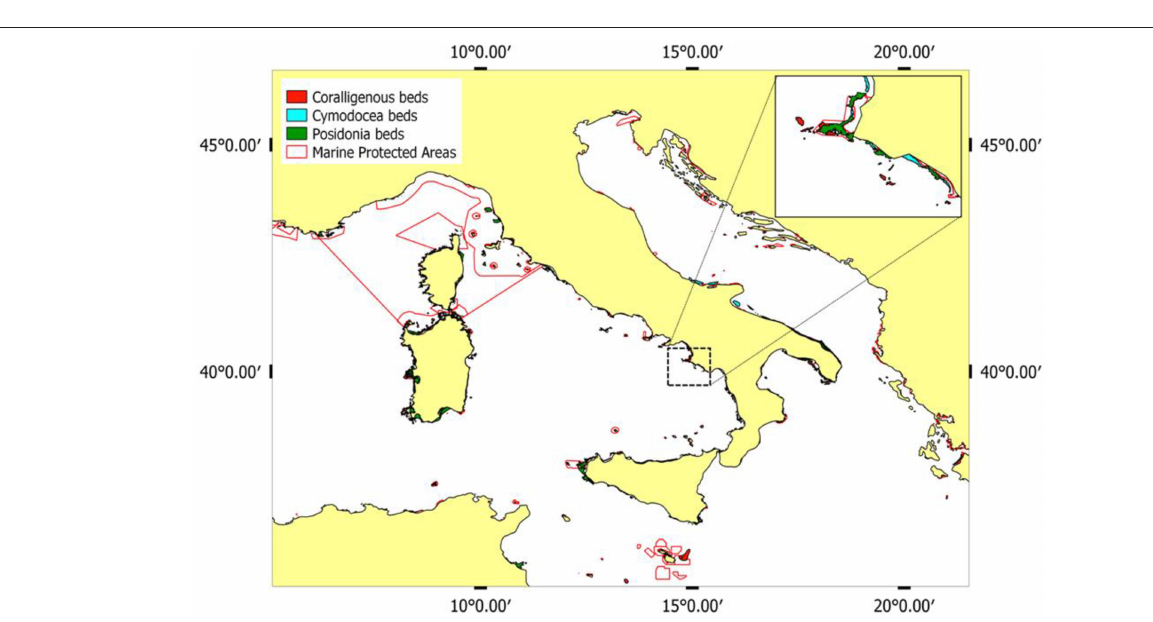
FIGURE 3 | Maps of MPA and